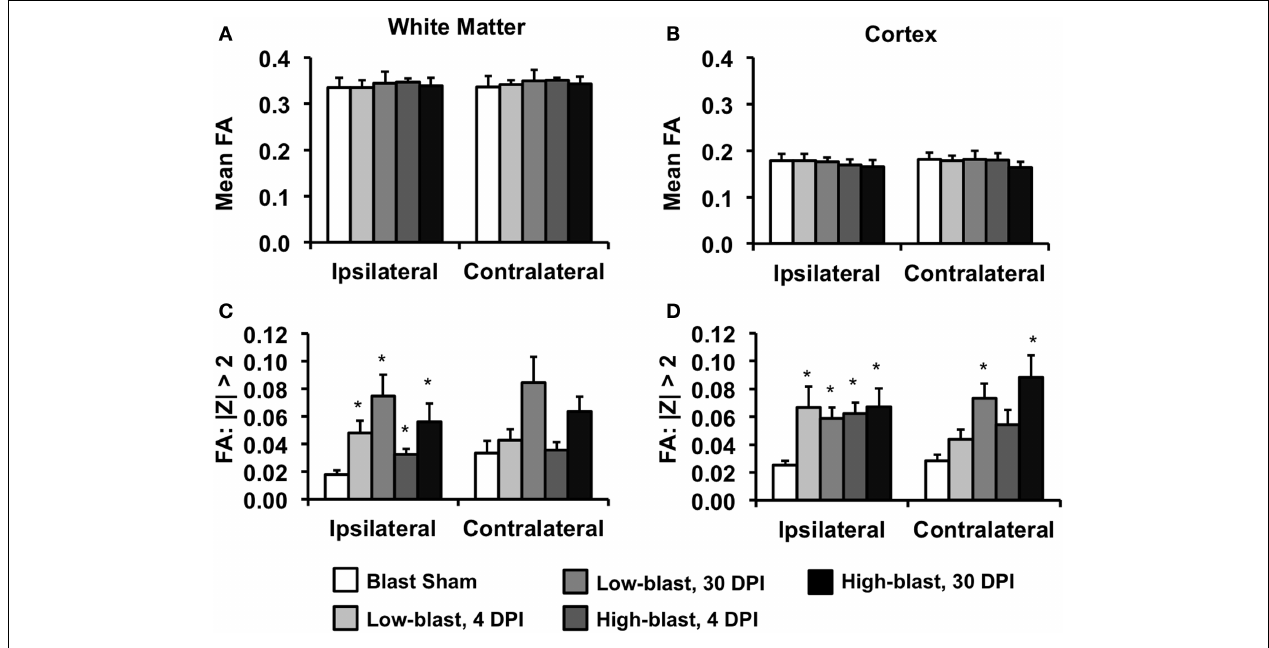
the ipsilateral or contralateral hemispheres. In the cerebral cortex (D) , the percentage of abnormal voxels ipsilateral to the blast exposure was significantly greater in all blast-exposed groups compared to the sham group. In the contralateral hemisphere, only groups 30days post-blast had a significantly greater percentage of abnormal FA voxel compared to the sham group. Error bars indicate standard deviation.* p < 0.05 compared to